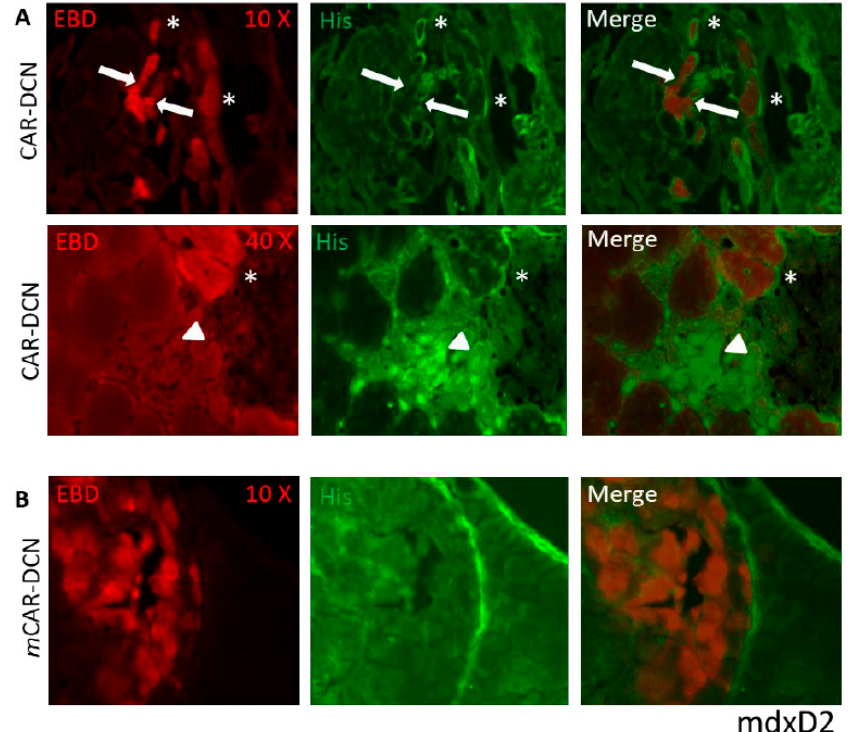
Figure 3. CAR-DCN localizes to sites of dystrophin deficient muscle damage. Staining of quadriceps muscles from mdxD2 mice injected IP, for three weeks with CAR-DCN or m CAR-DCN (in which the CAR homing peptide was mutated) reveals CAR targeted to sites of muscle damage by fluorescence microscopy. Slides were visualized with EBD for membrane permeability (red, first column) and anti-histidine antibodies for the recombinant proteins (green, middle column), and last column shows merged images. ( A ) The top row indicates co-localization of the CAR-DCN to the sarcolemma of damaged (red) cells and surrounding extracellular matrix (asterisks in top two rows). However, not all damaged cells have attracted the peptide (white arrows). The second row is a higher magnification illustrating CAR-DCN homing to regenerating skeletal muscle cells, which are negative for EBD and have likely resealed their membranes (arrow heads). ( B ) The quadriceps from mdxD2 mice were injected with m CAR-DCN. No co-localization of the peptide with damaged cells, in any pattern, was present. Original magnification for ( A ) panel top row and ( B ) panel was 10× and for ( A ) panel second row 40×.